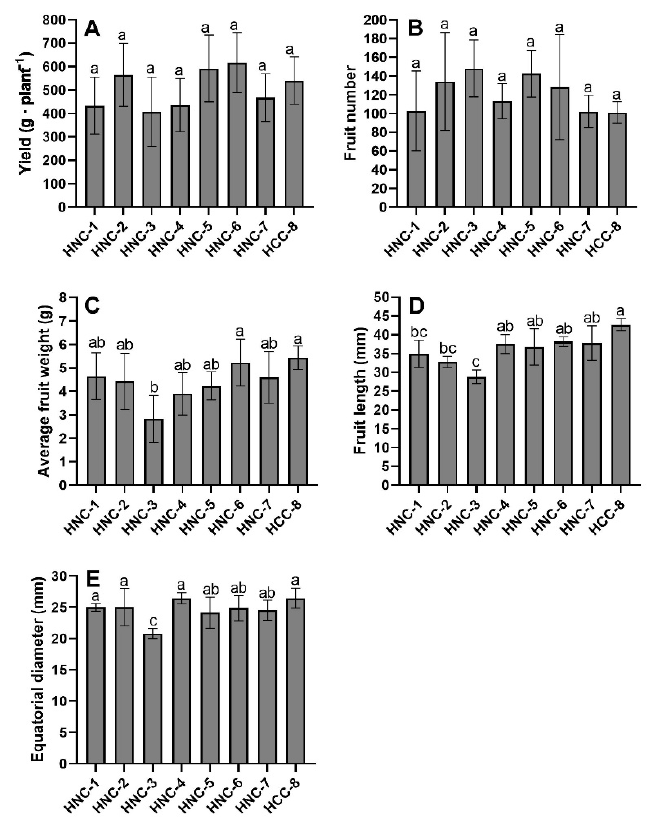
Figure 1. Yield ( A ), number of fruits ( B ), average fruit weight ( C ), fruit length ( D ), and equatorial diameter ( E ) of eight genotypes of habanero pepper grown in the southeast of Coahuila. Values are the average of four replications. Means ( n = 4). Bars represent the standard deviation of the mean. Different letters in each bar mean that the genotypes were statistically different (Tukey, p ≤ 0.05).